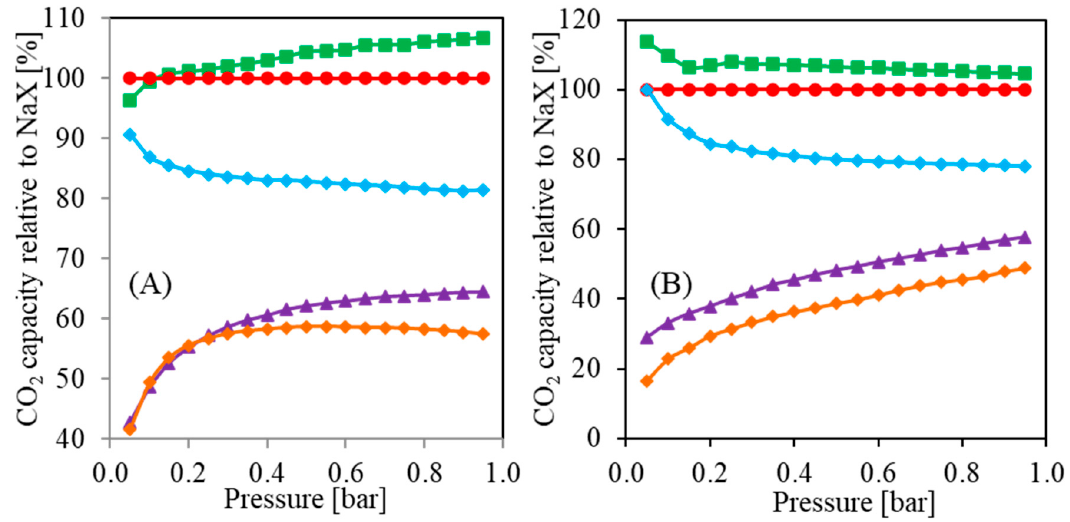
Figure 9. Relative capacity vs. pressure: ( A ) CO 2 sorption at 273 K; ( B ) CO 2 sorption at 298 K.